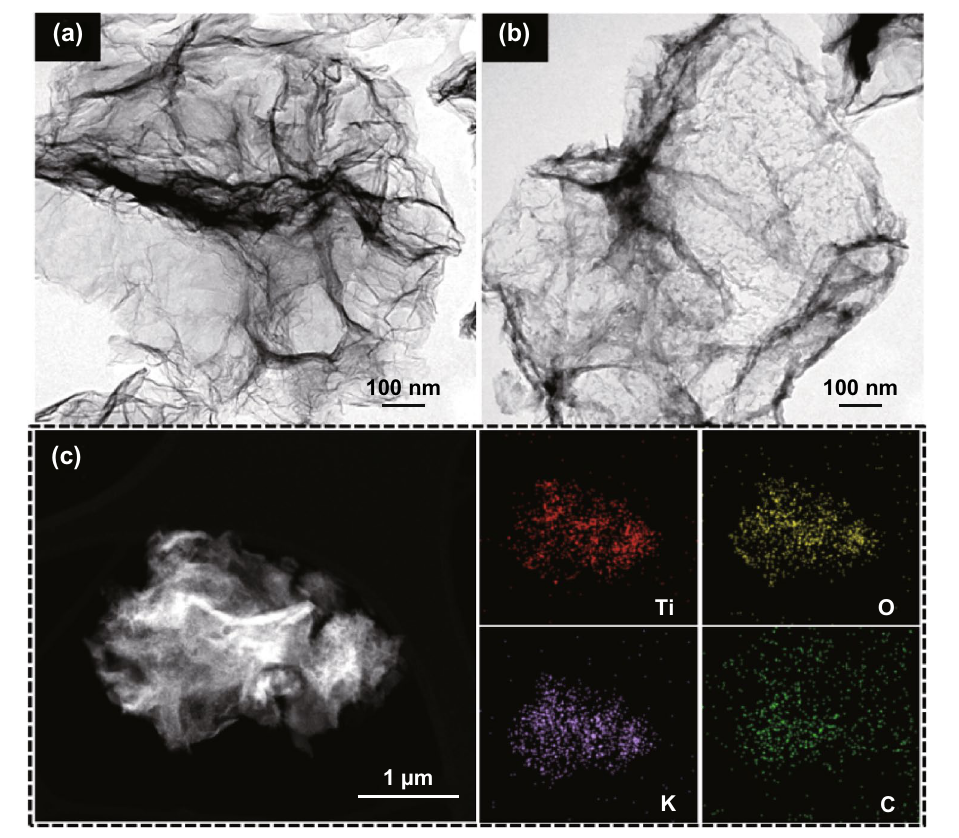
Fig. 4 TEM images of the a GR crumples, b KTO NP/PGC composites prepared at weight ratio of GO:KOH:TiO 2 for 1:3:0.25 (reaction tem‑ perature: 200 °C, gas flow rate: 10 L min −1 , post‑heat treatment: 700 °C, 2 h), c EDS elemental mapping analysis of KTO NP/PGC composites